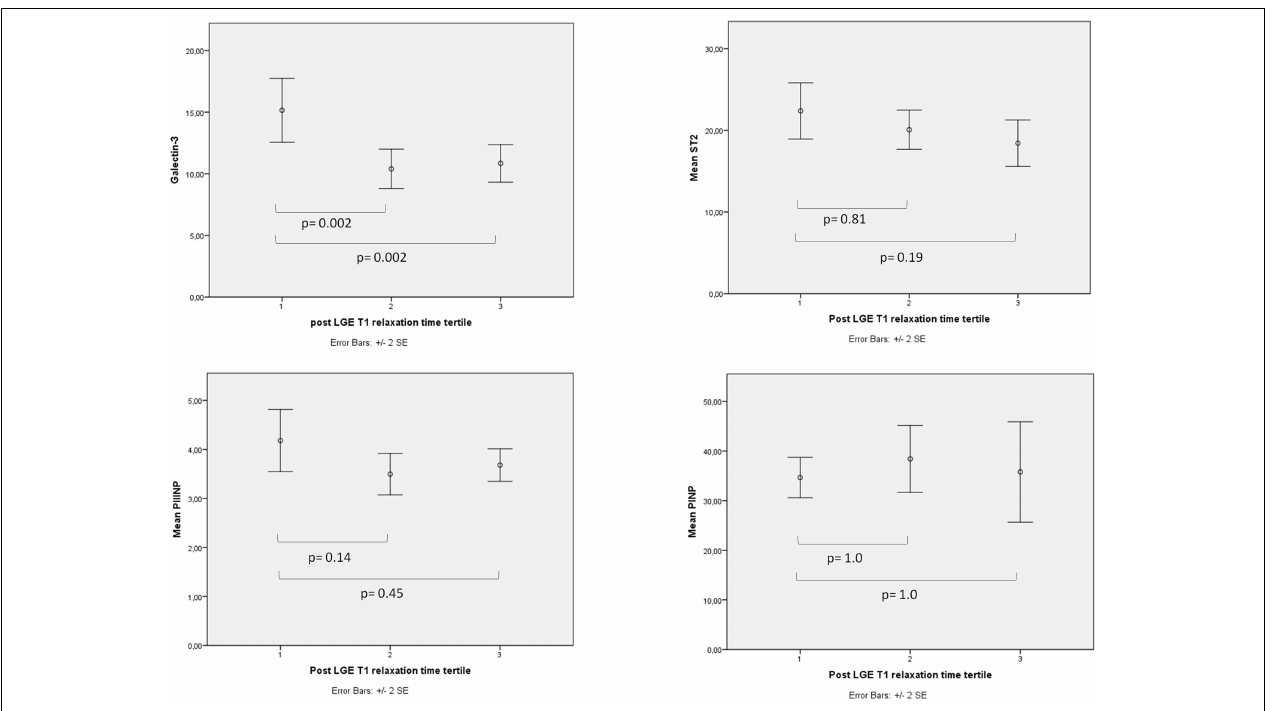
highest amount of interstitial fibrosis) Galectin-3 was the only biomarker of fibrosis that was significantly higher in the 1st tertile compared to the other two tertiles.